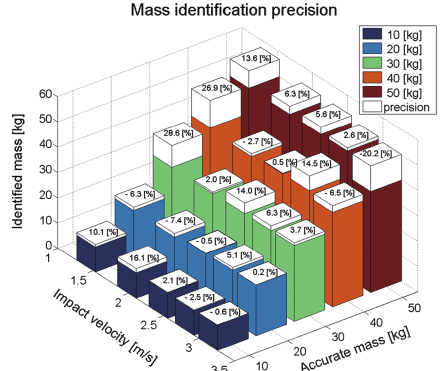
Fig. 11. Velocity identi fi cation, experimental results: (left) initial pressure 20 kPa, (right) initial pressure 100